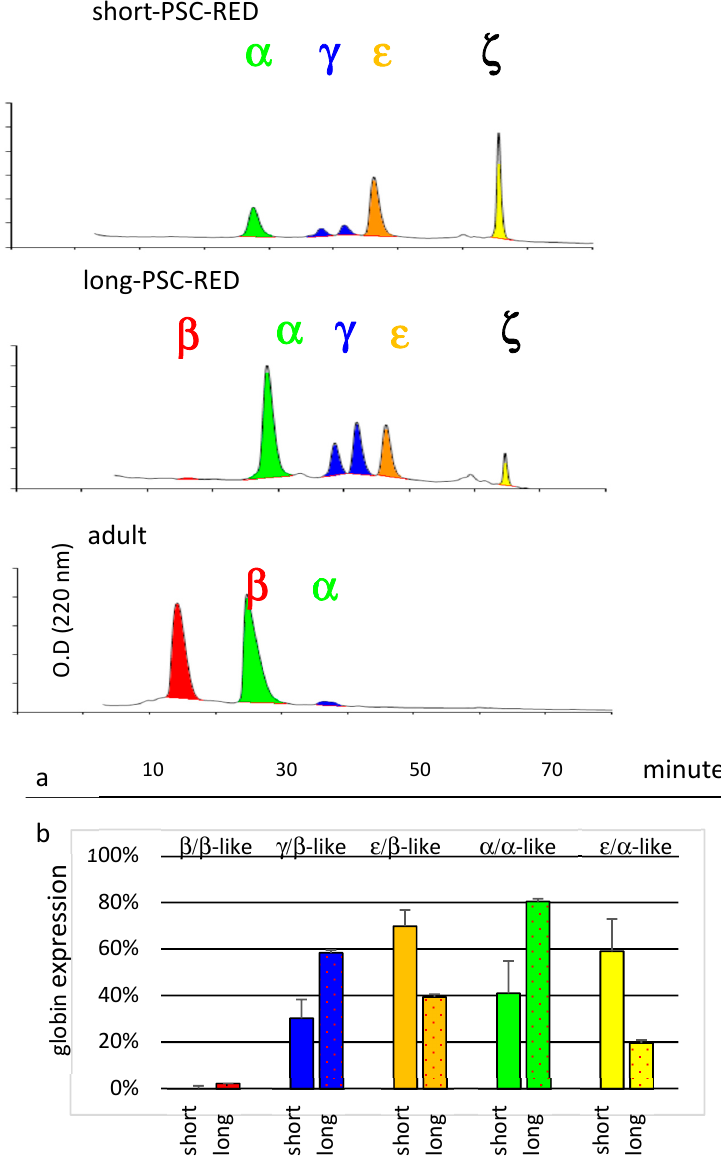
Figure 6. Globin expression. ( a ) HPLC chromatograms illustrating globin expression. Cultured RBCs obtained at day 32 (short-protocol) or 36 (long-protocol) were lysed and analyzed by HPLCs. RBCs from an adult baboon were used as controls (lower chromatogram). ζ and ε -globins are expressed at lower levels in cells obtained with the short protocol; ( b ) histograms summarizing the results of the HPLC analysis. Percentage of a-like = 100 × ( α or ζ ) / ( α + ζ ). Percentage of β -like = 100 × ( ε ( G α + A γ ) or β ) / ( ε + G γ + A γ + β ). Data are the average ± SEM of four independent experiments. The long PSC-RED protocol yields more developmentally mature cells. RED protocol expressed a mixture of about 70% ε -globin and 30% γ -globin from the β -like